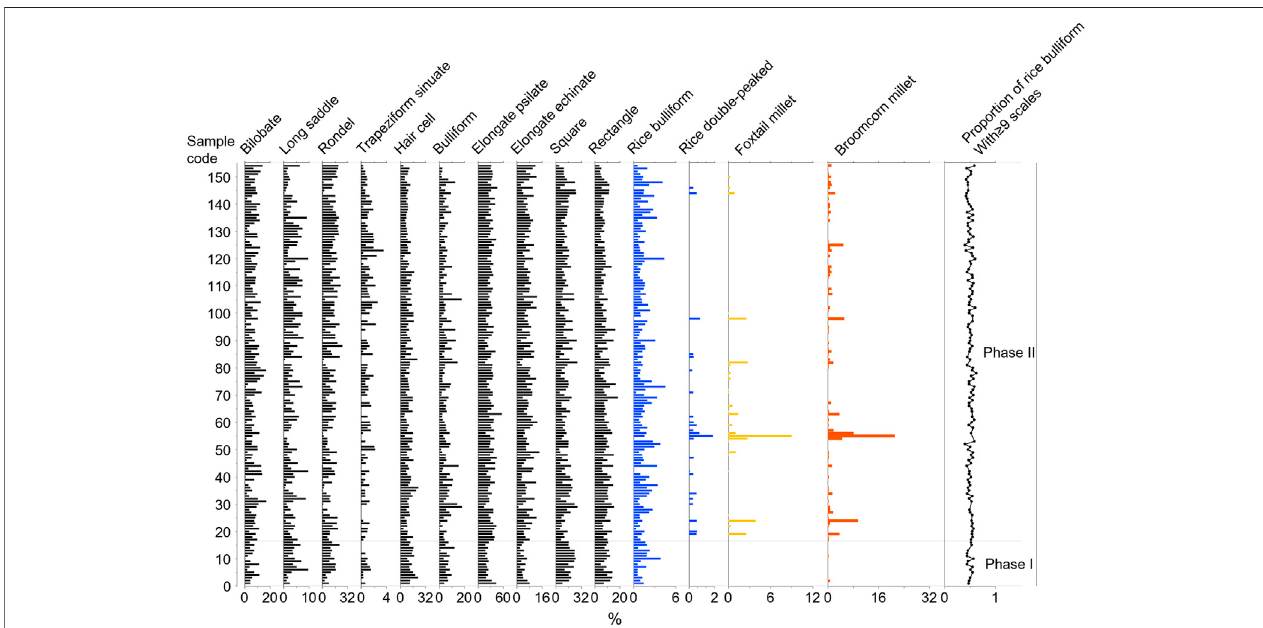
FIGURE 3 | Percentage diagram of major phytolith types at the Guijiabao site. Sample code in Supplementary Table S1 .